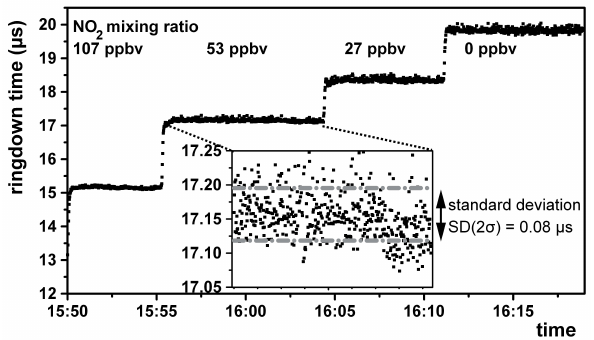
Fig. 9. Allan variance of the 53ppbv NO 2 (black dots) and the 107ppbv NO 2 (black crosses) in synthetic air measurement as de- picted in Fig. 8. The red line corresponds to the black dots and in- dicates a slope of − 1 . 0 which is expected for white noise only.